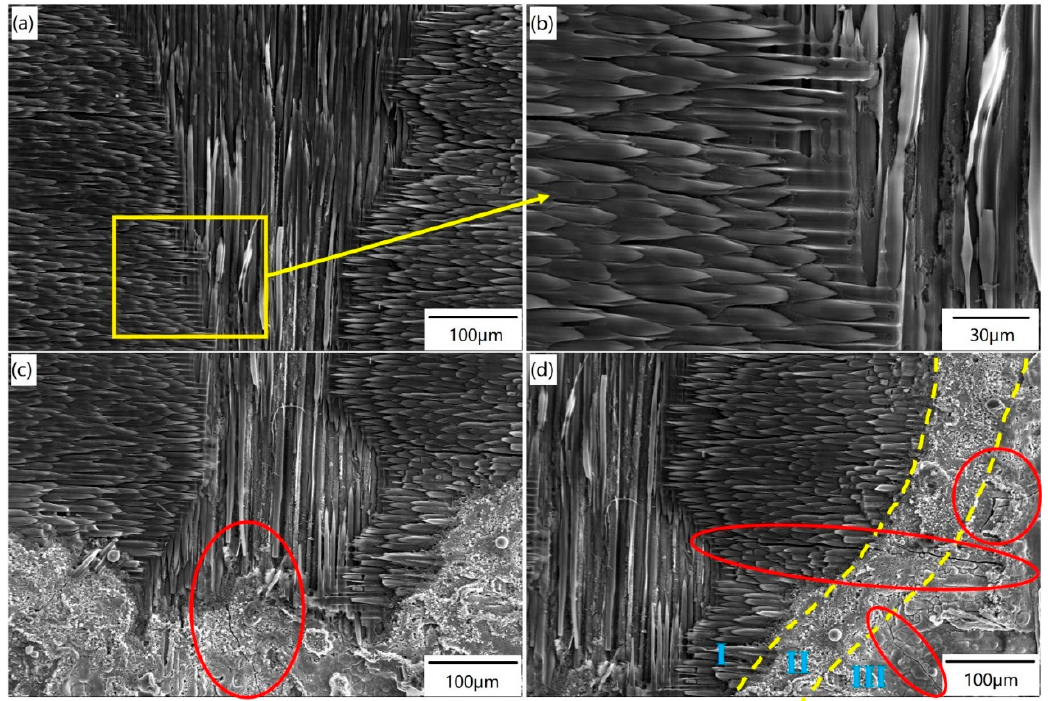
Figure 4. Different areas on the irradiated surface under Condition F: ( a , b ) center region; ( c ) transition region; ( d ) border region.